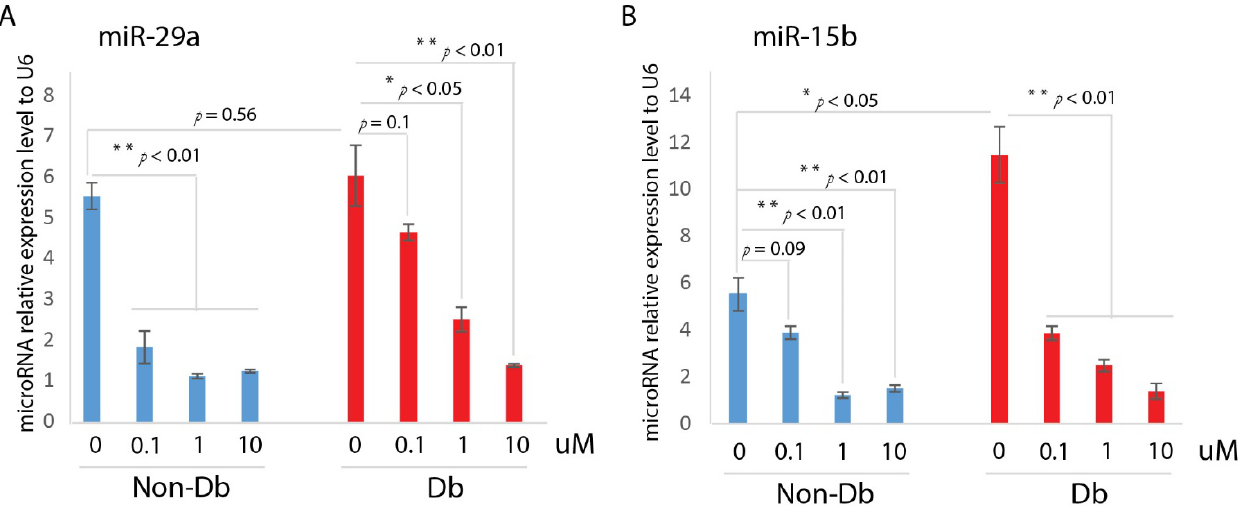
Figure 3. MiR-29a and miR-15b expression level was decreased with UCUF-728 treatment in Human dermal fibroblast. ( A ) Realtime qPCR (mean ± SD, n = 3 per group) analysis of miR-29a gene expression relative to internal control U6 in human diabetic dermal fibroblasts and non-diabetic dermal fibroblasts with UCUF-728 treated at dose of 1, 0.1, 1 and 10 uM. ( B ) Realtime qPCR (mean ± SD, n = 3 per group) analysis of miR-15b gene expression relative to internal control U6 in human diabetic dermal fibroblasts and non-diabetic dermal fibroblasts with UCUF-728 treated at dose of 1, 0.1, 1 and 10 uM. * p < 0.05; ** p <